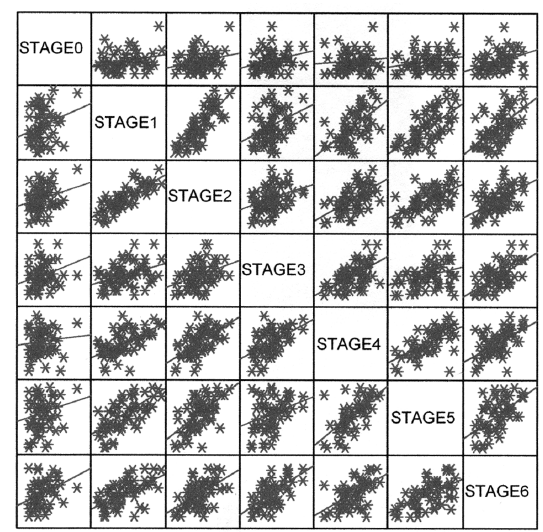
Figure 6: Correlation between